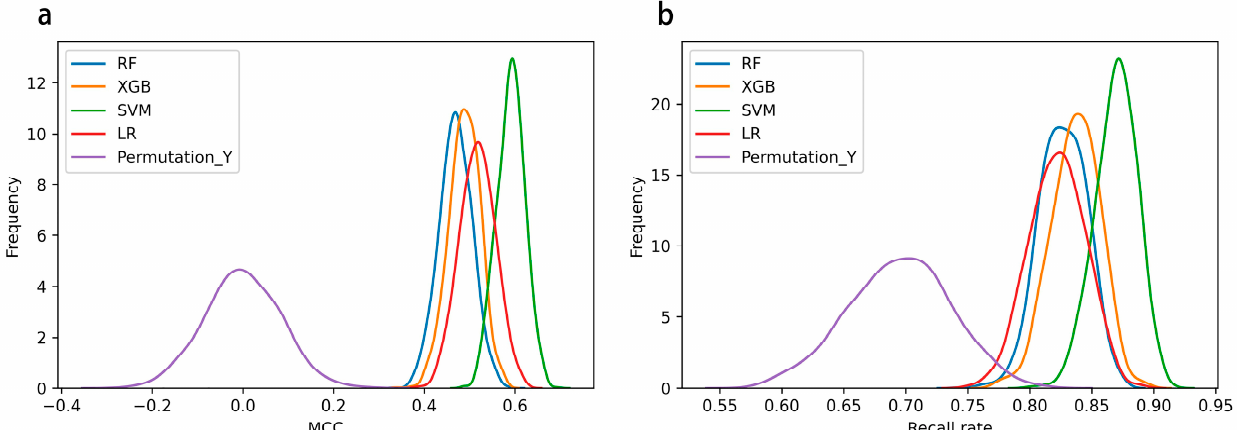
Figure 2. MCCs and recall rates achieved by SMV, LR, RF, and XGBoost with 1000 iterations of five-fold cross-validation and by SVM with permutation dataset. ( a ) The distribution of MCCs achieved by four models and SVM with permutation dataset. ( b ) The distribution of recall rates achieved by four models and SVM with permutation dataset. Table 2. Prediction results of RF, XGBoost, SVM, LR, and Permutation_Y.